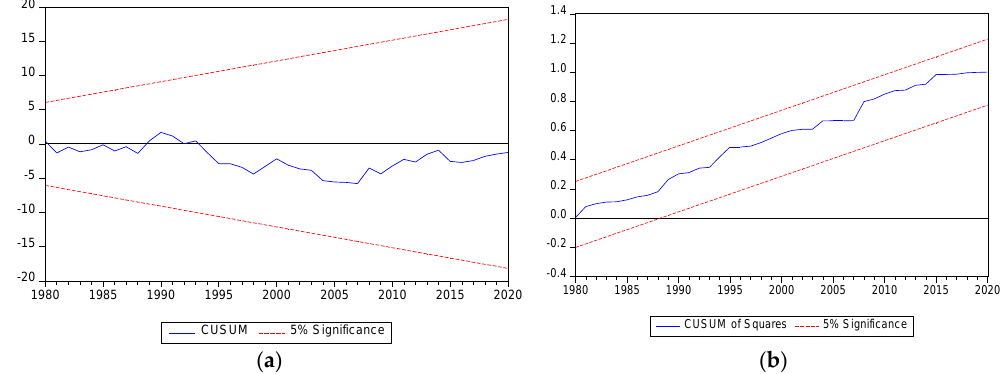
Figure 7. ( a ) CUSUM Test for Model 1. ( b ) CUSUMQ Test for Model